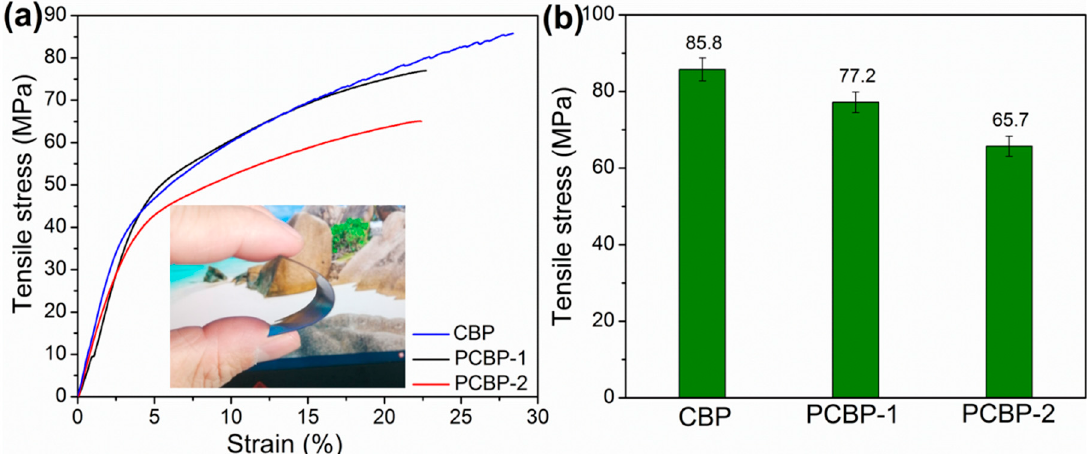
Figure 6. Representative stress–strain curves ( a ) and tensile strength ( b ) of CBP, PCBP-1 and PCBP-2. The inset is a digital image of PCBP-2 to show good mechanical robustness and flexibility.